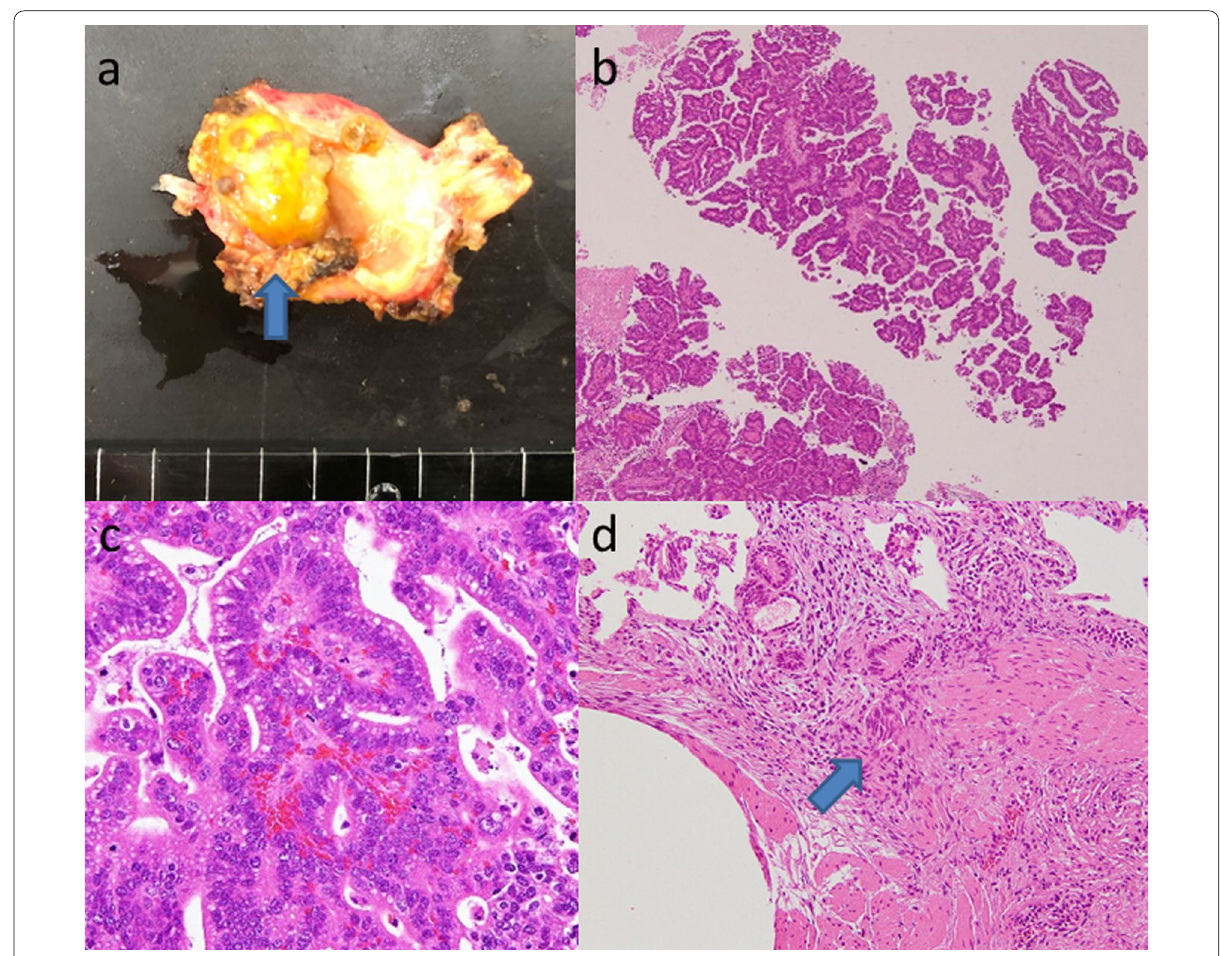
Fig. 5 Macroscopic and microscopic findings of the resected specimen. a A 12-mm yellowish papillary exophytic mass (arrow) distinct from the adjacent mucosa is observed in the remnant gallbladder (the remnant gallbladder is on the left side, and the cystic duct is on the right side). b The tumor consisted of atypical glandular epithelium with mild-to-severe dysplasia arranged in a high papillary architecture with thin fibrovascular stalks (hematoxylin–eosin (H&E) staining, 40). c Biliary morphology with cuboidal cells showing clear to eosinophilic cytoplasm, enlarged nuclei, × and prominent nucleoli (H&E, 200). d Focal stromal invasion in the muscle is visible (arrow). (H&E, × ×